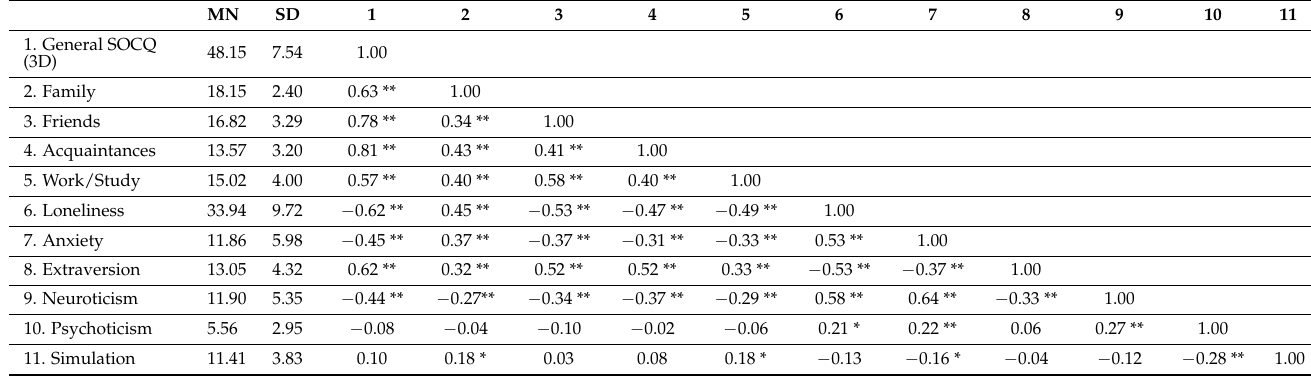
Table 4. General correlations between the